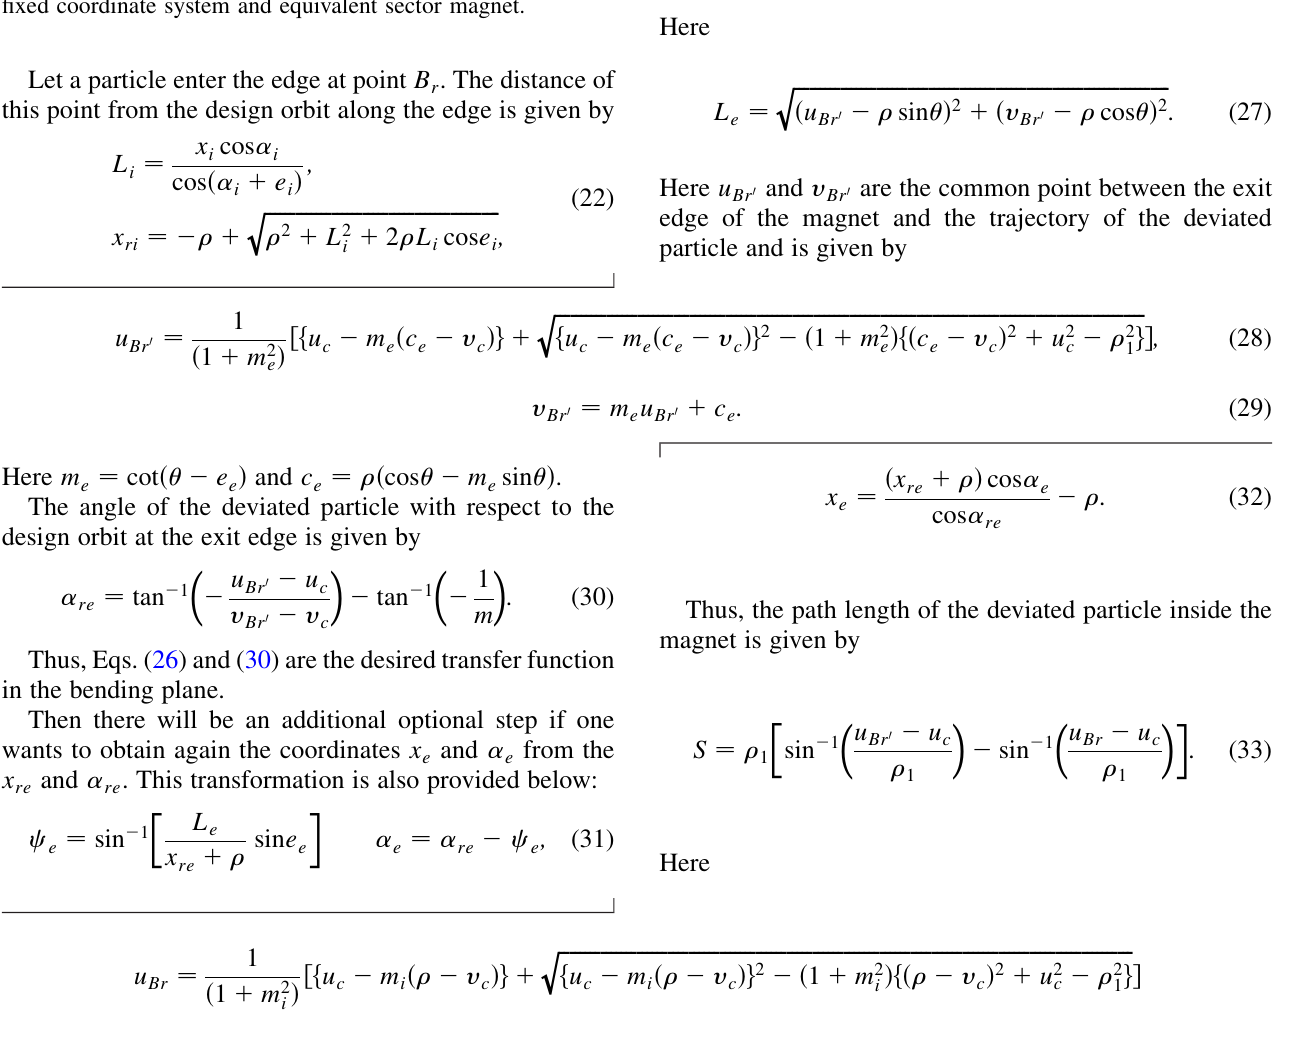
FIG. 12. Geometry of design trajectory and a deviated particle trajectory in the median plane of a wedge dipole magnet with fixed coordinate system and equivalent sector